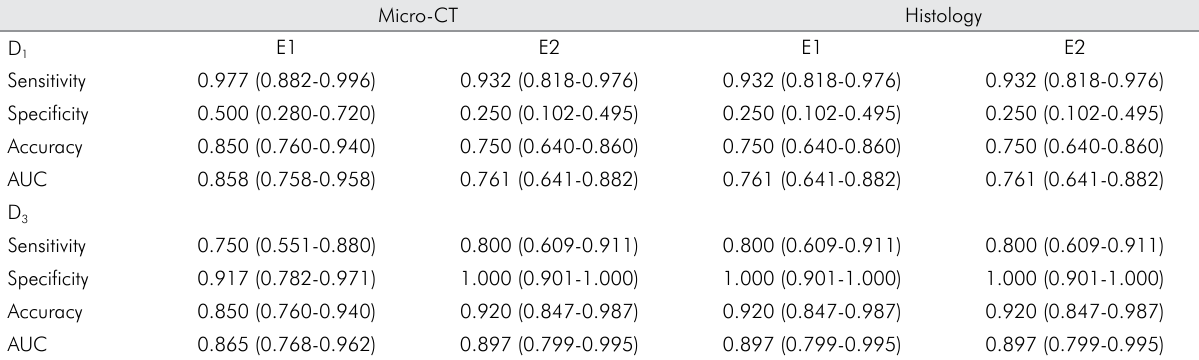
Table 4. Sensitivity, specificity, accuracy, and AUC values with respect to 95% confidence intervals for ICDAS-II associated with micro-CT and histological examination at both